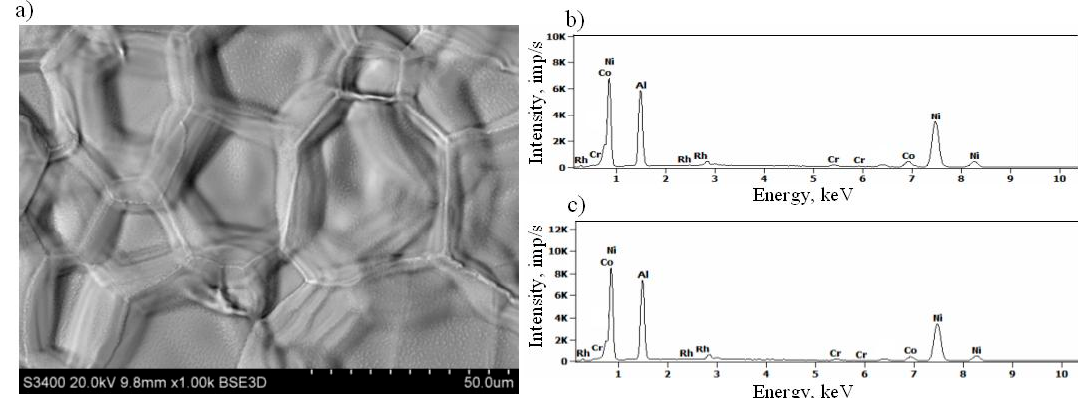
Figure 5. Surface morphology ( a ), EDS spectrum of grain core ( b ) and EDS spectrum of grain boundary ( c ) of the rhodium-modified aluminide coating.